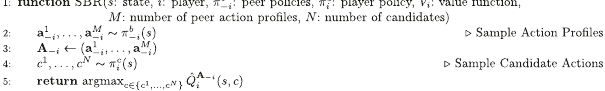
Algorithm 1 Sampled Best Response.